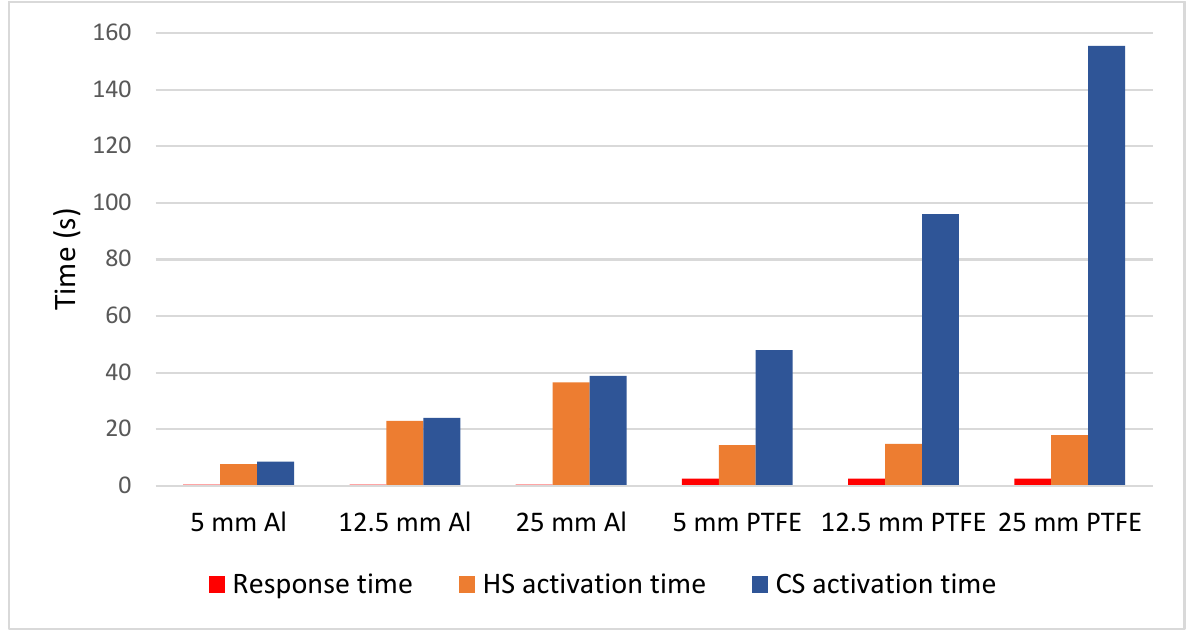
Figure 16. Heating times distribution.